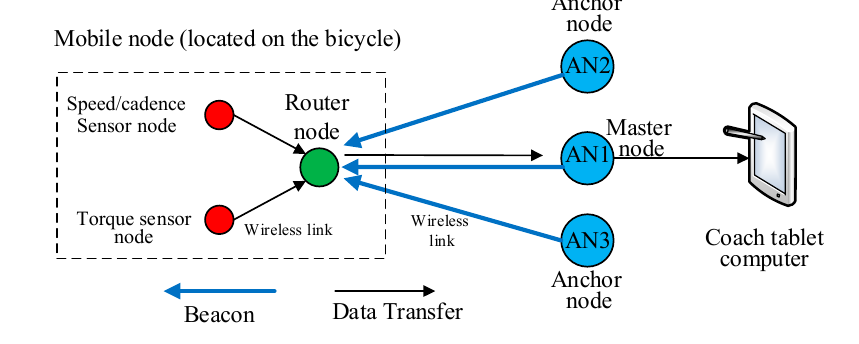
Figure 2. BWSN topology.